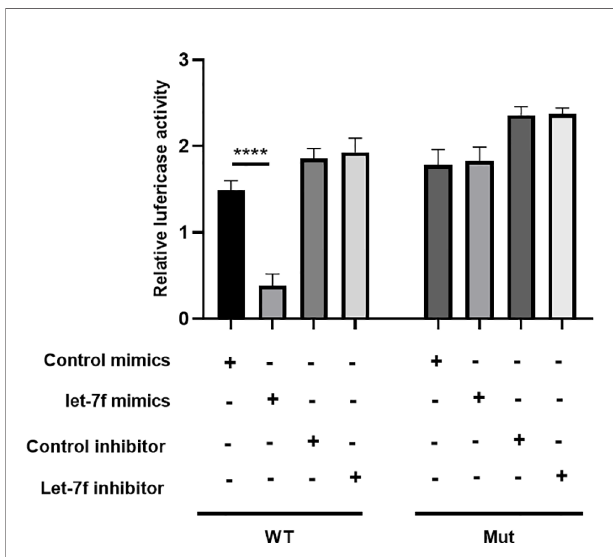
FIGURE 8 | Luciferase reporter assay was evaluated the target relationship between let-7f and ULK2. **** p <